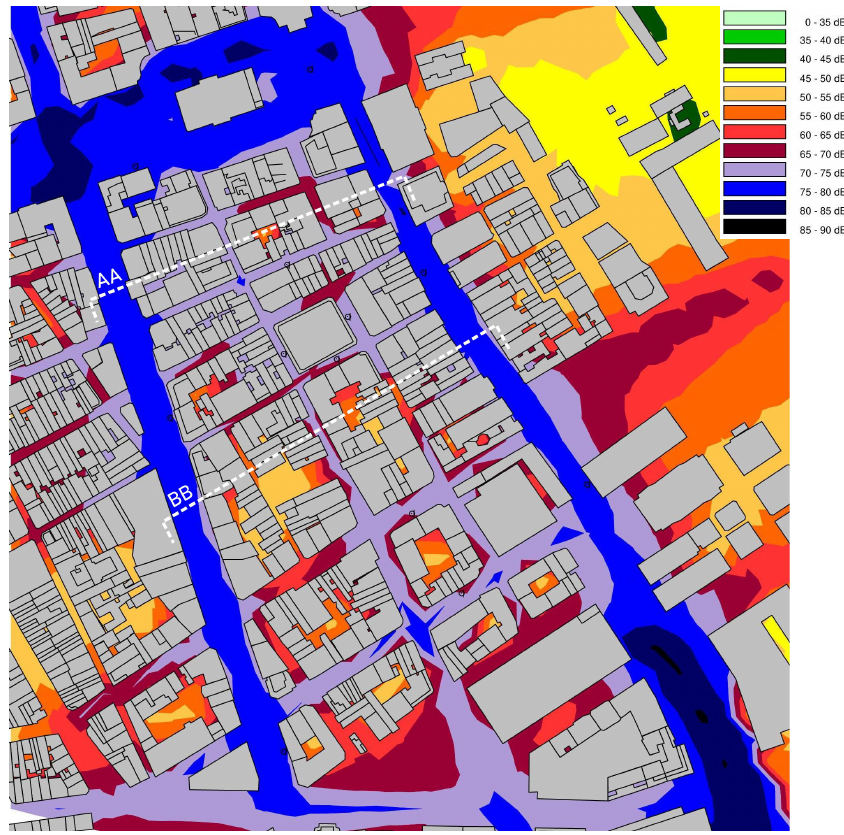
Figure 8: Noise map for scenario before